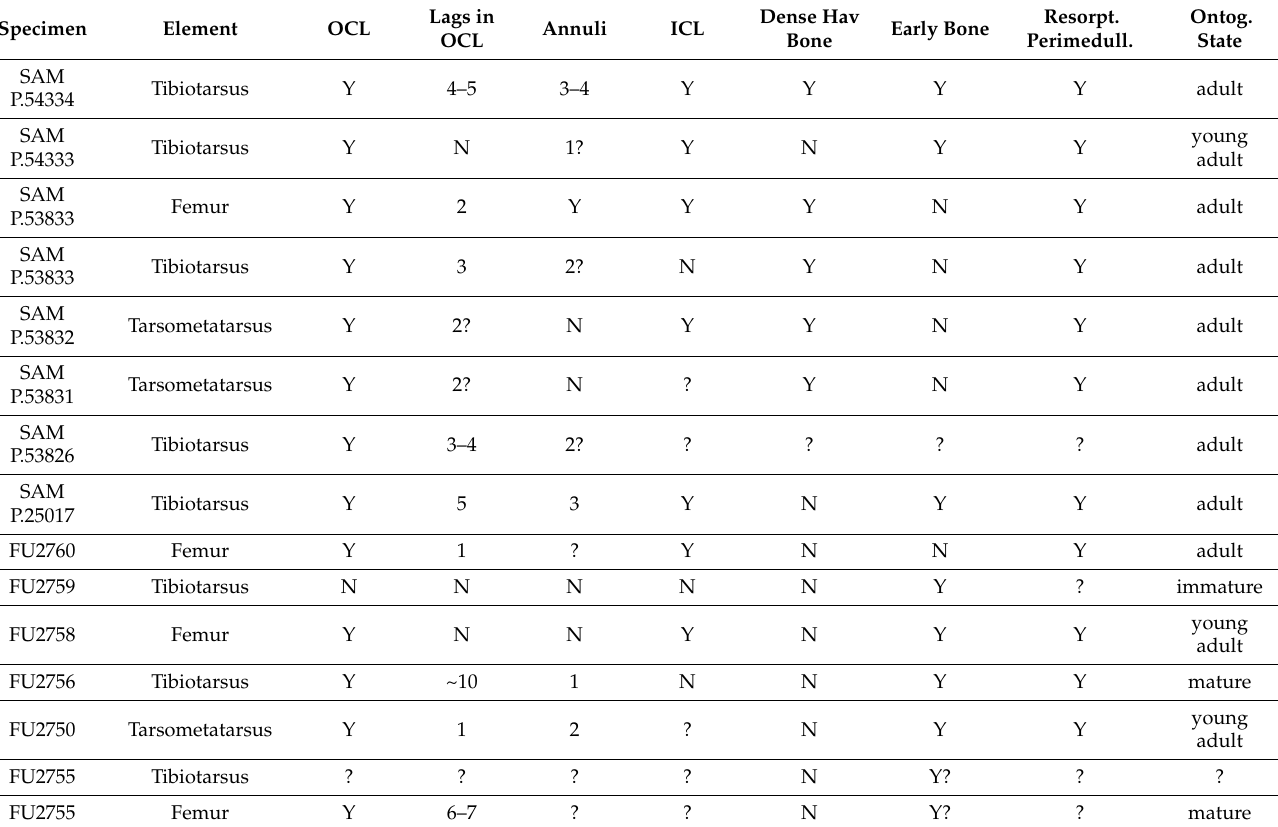
Table 2. Summary of histology data for specimens studied. Spec. no., specimen number; OCL, outer circumferential layer; Lags, lines of arrested growth; ICL, inner circumferential layer; hav, Haversian; Resorpt. Perimedull., resorption cavities in the perimedullary region; Ontog., ontogenetic. Y denotes presence, N denotes absence and ? denotes uncertain.